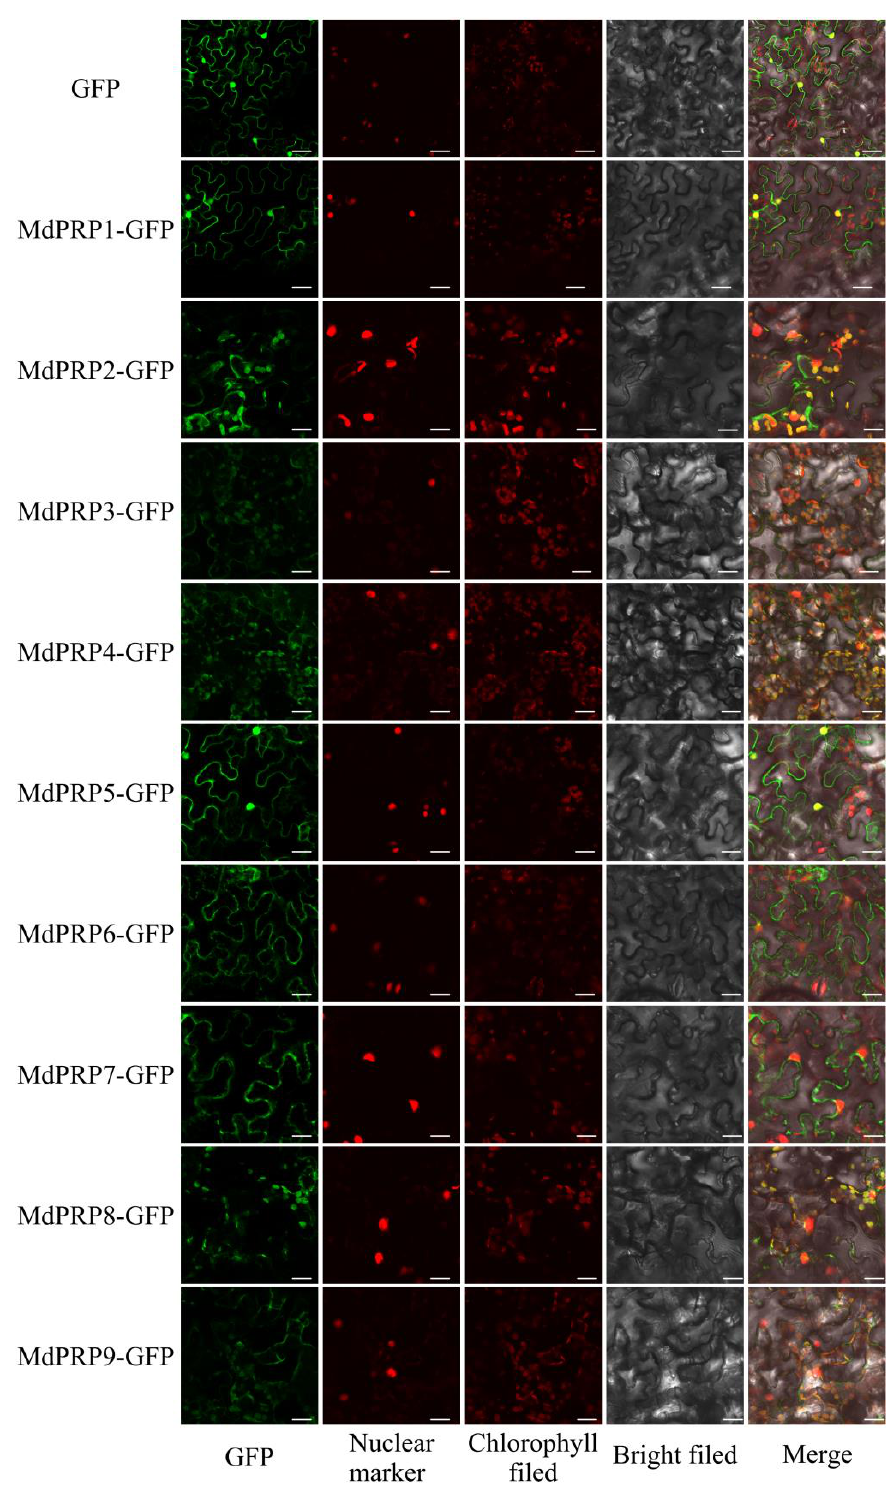
Figure 6. Subcellular localization analysis of MdPRPs. Fusion plasmid (35S MdPRP-GFP), with MdHB-7-mRFP driven by CaMV 35S promoter, were transiently cotransformed into tobacco epidermal cells. Fluorescence images were obtained using confocal microscopy (FV1000; Olympus, Tokyo, Japan). GFP image means Green fluorescent protein; Nuclear marker image means MdHB-7-mRFP (Red fluorescent protein); Chlorophyll field means Chloroplast autofluorescence; Merge means image GFP and image MdHB-7-mRFP and image chlorophyll merged with its bright-field photograph in same cell. Scale bar = 50 µ